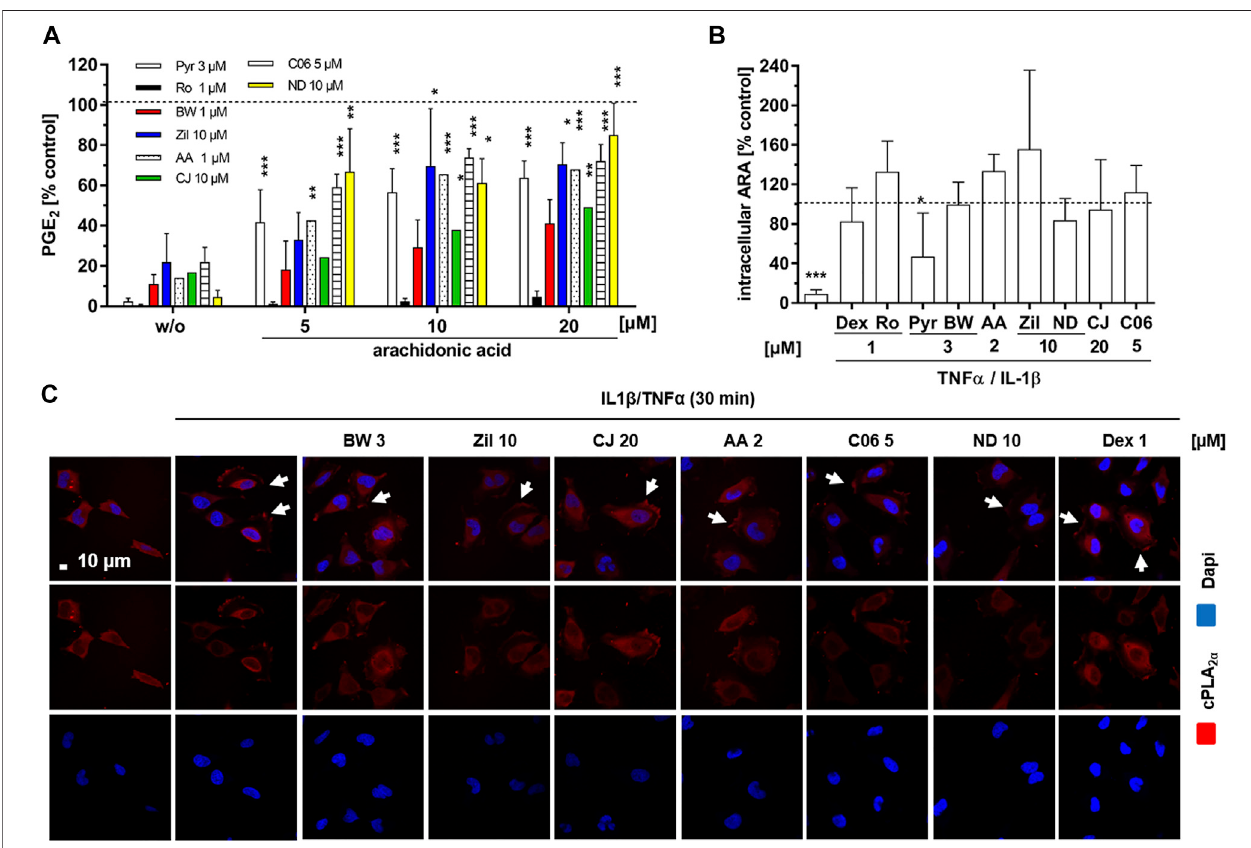
FIGURE 4 | In fl uence on cPLA 2 α translocation and arachidonic acid liberation in HeLa cells. (A) HeLa cells were treated with cytokines (IL-1 β 1 ng mL − 1 , TNF α 5 ng mL − 1 ), the inhibitors (1 μ M AA-861, 10 µM zileuton, 10 µM CJ-13,610, 3 μ M BWA4C, 10 µM NDGA, 5 µM C06) or vehicle (DMSO) plus increasing concentrations of ARA (5 – 20 µM) for 5 h and PGE 2 concentrations in the cell culture supernatants were assessed by ELISA. The COX-2 inhibitor rofecoxib (1 µM) and the cPLA 2 α inhibitor Pyr (3 µM) were used as controls. Mean PGE 2 release from cytokine treated (5 h) HeLa cells: without ARA 4.69 ± 1.3 ng mL − 1 ; with 5 µM ARA 29.09 ± 5.2 ng mL − 1 ; with 10 µM ARA 31.6 ± 4.87 ng mL − 1 ; with 20 µM ARA 40.16 ± 6.97 ng mL − 1 . (B) To measure intracellular ARA liberation, HeLa cells were treated with cytokines (IL-1 β 1 ng mL − 1 , TNF α 5 ng mL − 1 ) and the inhibitors (2 μ M AA-861, 10 µM zileuton, 20 µM CJ-13,610, 3 μ M BWA4C, 10 µM NDGA, 5 µM C06) or vehicle (DMSO) for 1 h and intracellular ARA was assessed by LC-MS/MS. 1 µM dexamethasone, 1 µM rofecoxib and 3 μ M Pyr served as controls. Mean intracellular ARA concentrationincytokinetreated(1 h)HeLacellswas12.47 ± 4.69 ng Mio − 1 cells. (C) ConfocalmicroscopytoinvestigatecPLA 2 α